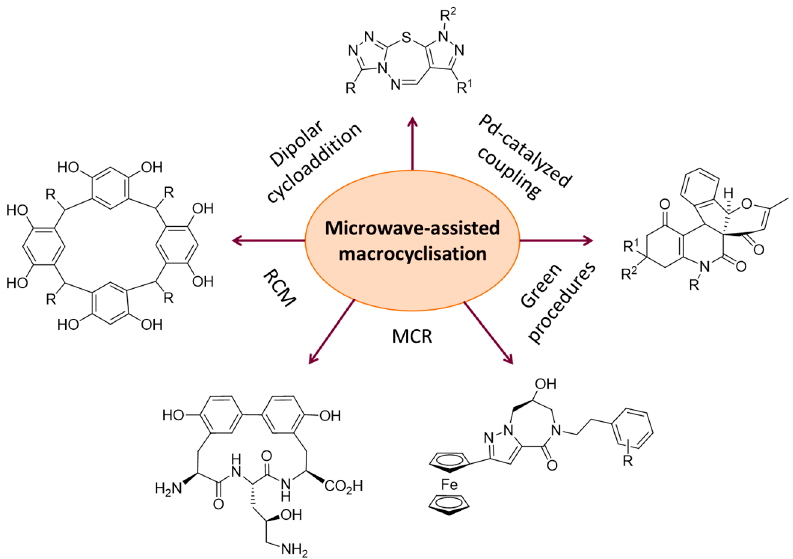
Figure 13. The large scope of the MW-assisted macrocyclisations.